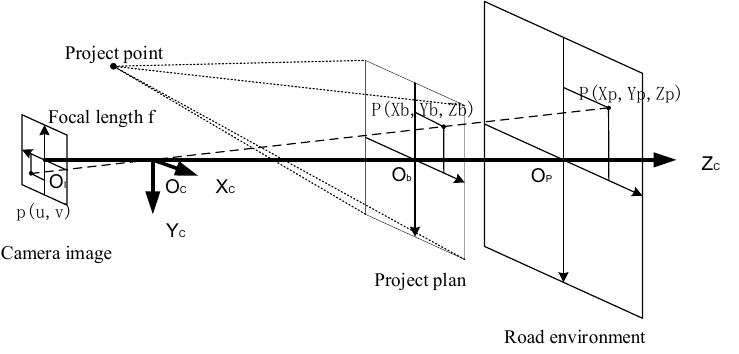
Figure 4. Design principle of virtual road simulation.